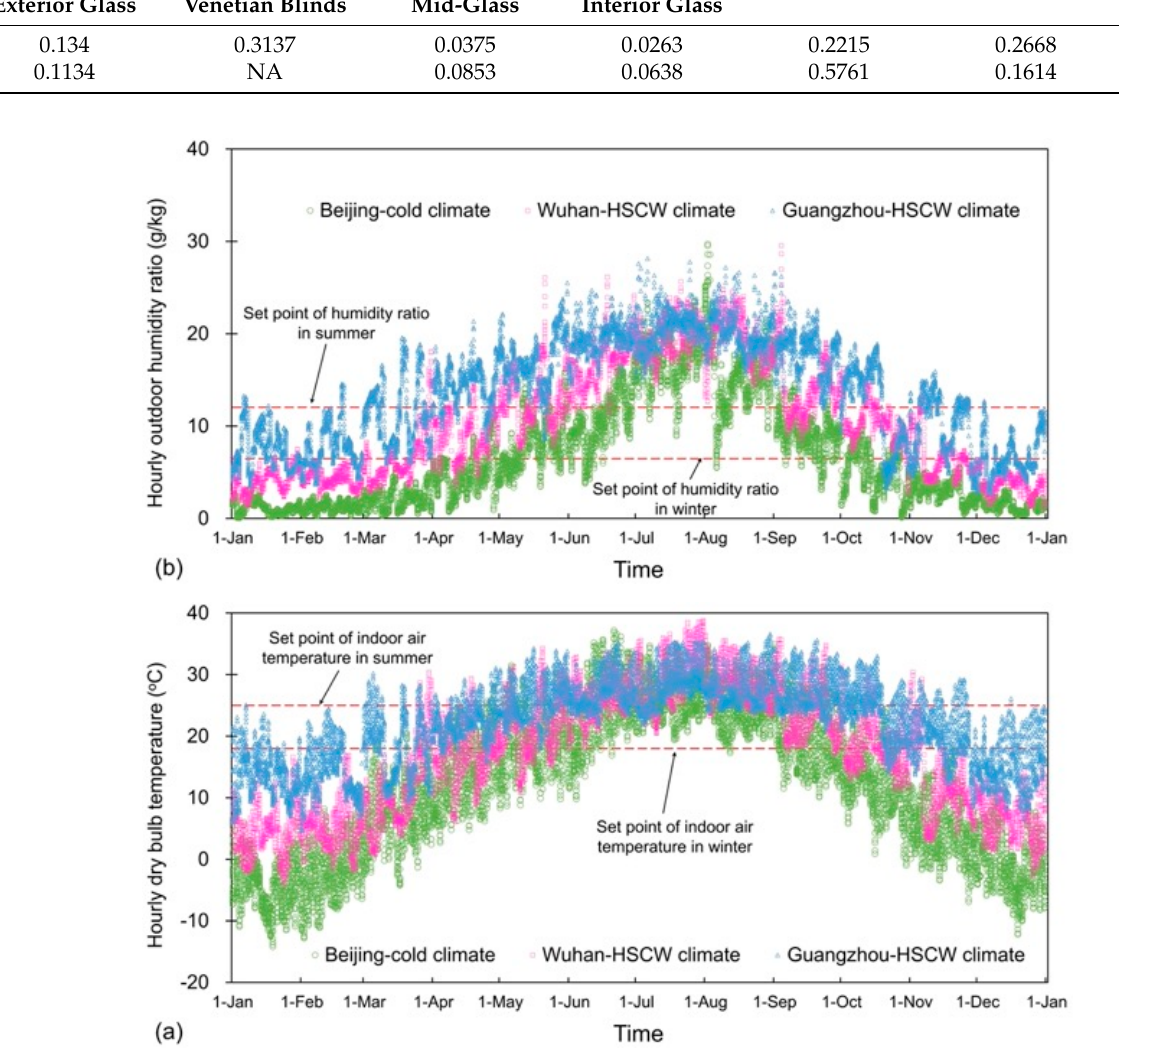
Figure 6. Hourly weather conditions of the three different climate zones: ( a ) dry bulb temperature; ( b ) humidity ratio.